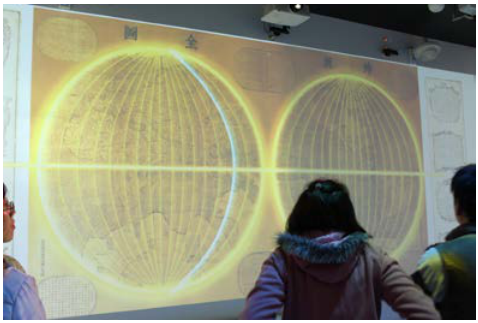
Figure 4. Animation of geographic coordinate system is vividly presented in front of participants.